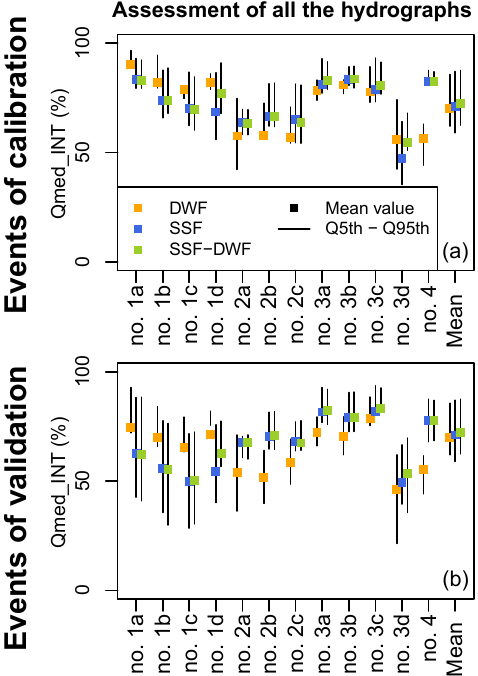
Figure 6. Qmed_INT scores, with mean Qmed_INT scores ob- tained for the calibration (a) and validation (b) events, by model and catchment. The Qmed_INT scores were calculated for the whole hydrograph. The x axis refers to the ID number of each catchment (Fig. 1). Finally, the mean attribute refers to the average results over all the catchments obtained with each